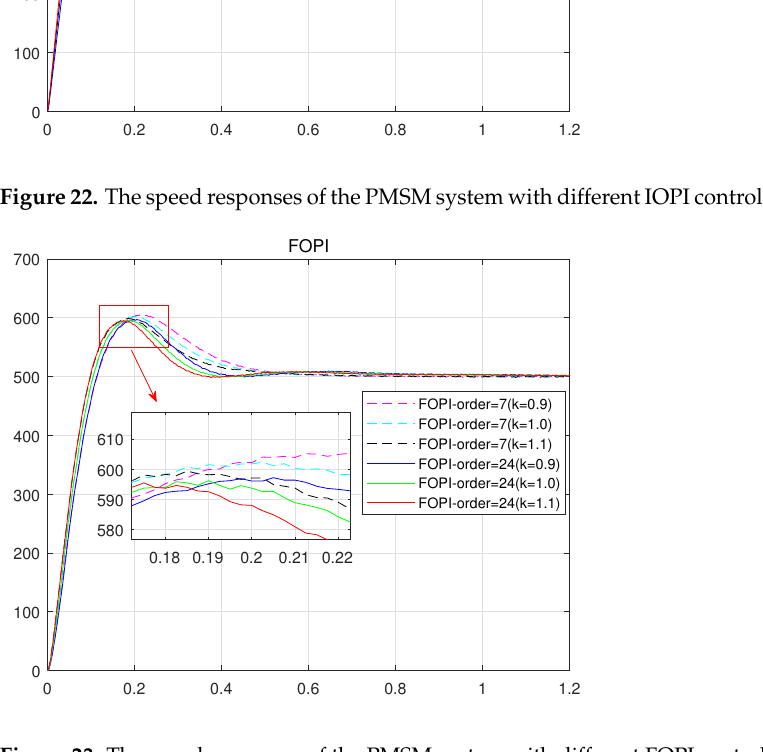
Figure 23. The speed responses of the PMSM system with different FOPI controller gains (Experiment).